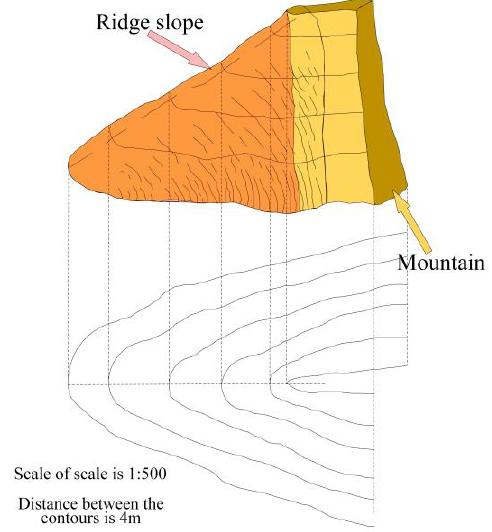
Figure 1. Diagram of a ridge slope.